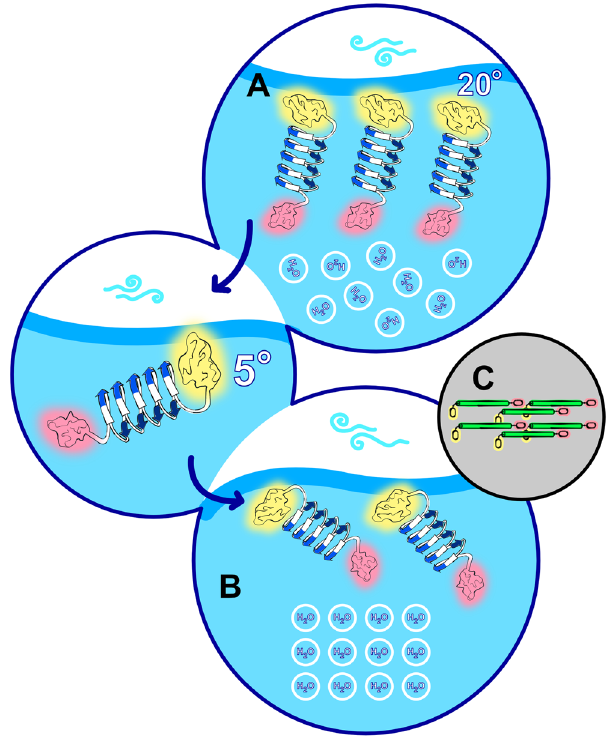
Fig. 6 Illustration of the interaction of InaZ9R with water molecules. A At room temperature, the ice-nucleating sites (blue arrows, N- and C- terminal domains marked yellow and pink, respectively) are buried in the protein fi lm resulting in relatively low water order. B At 5 °C, InaZ9R reorients with the long axis of the helix more parallel to the surface. In this orientation the ice- nucleating sites are exposed to the interfacial water layer. Although the speci fi c water orientation cannot be inferred from homodyned SFG data, the results clearly show increased water order, which promotes ice nucleation. C The low-temperature protein pose, with the β -helix (green) axis of InaZ parallel to the surface, and the N- and C termini again marked yellow and pink, supports recent models for INP assembly at bacterial